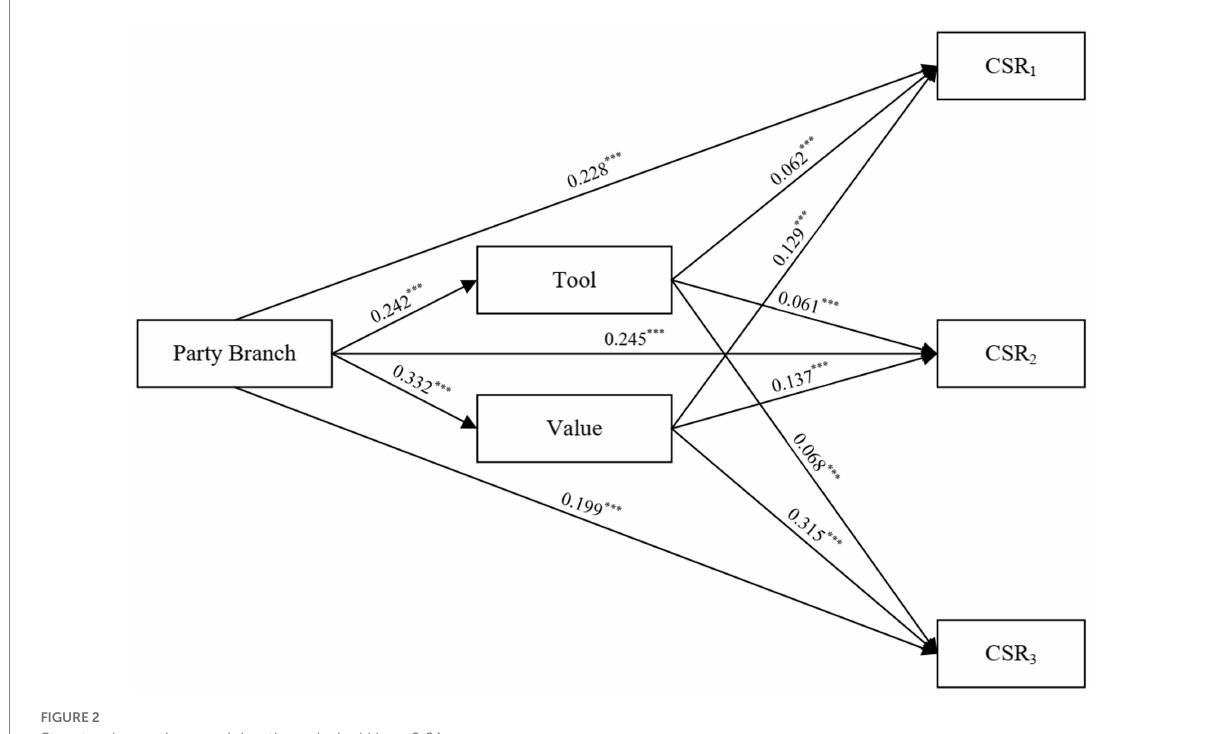
FIGURE 2 Structural equation model path analysis. *** p < 0.01.